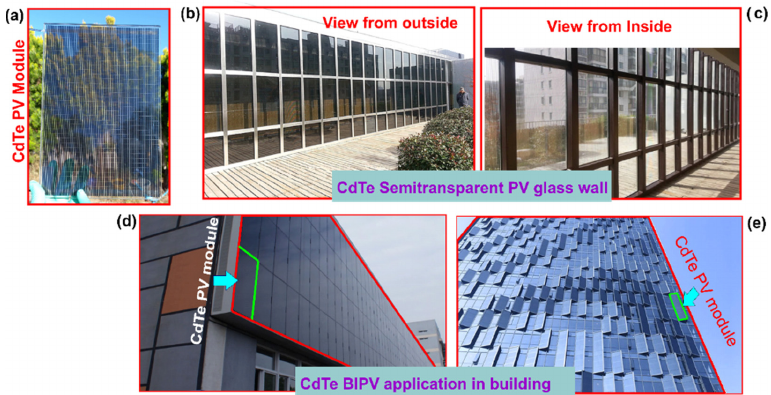
Figure 9. CdTe-based semitransparent BIPV ( a ) ASP CdTe semitransparent PV module, ( b ) Outside view (reproduced and modi fi ed from [84]), ( c ) inside view (reproduced and modi fi ed from [84,85], ( d ) Application of CdTe Thin-Film based semi-transparent PV Glass as BIPV façade (reproduced and modi fi ed from [85] and ( e ) Application of CdTe Thin-Film based semi-transparent PV Glass as BIPV curtain wall (reproduced and modi fi ed from [85]).